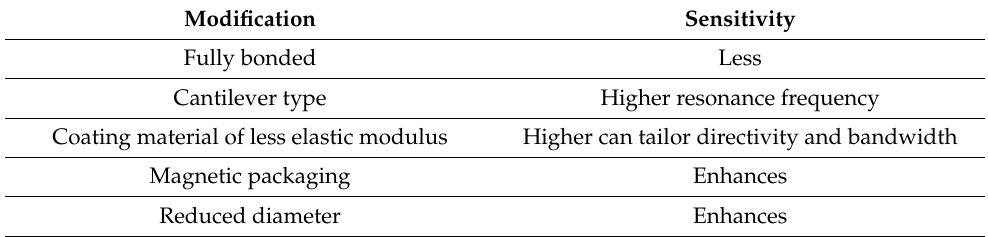
Table 1. Effect on physical configuration of the sensor on